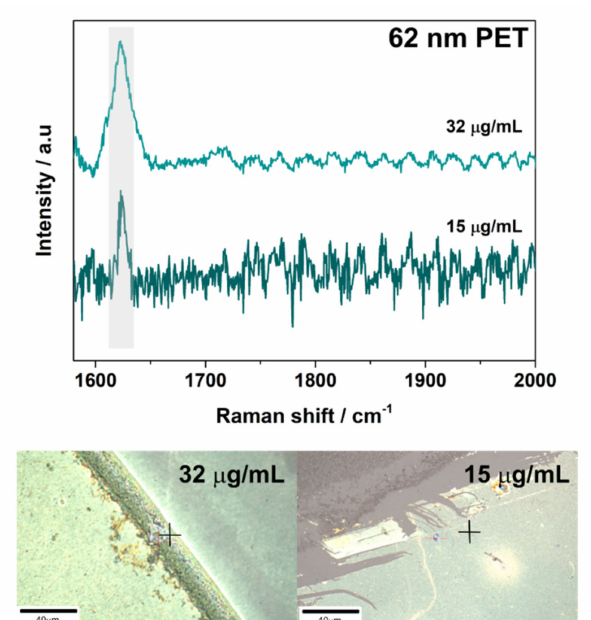
Figure 3. A representative SERS spectrum obtained for 62 nm PET nanoparticles on 46 nm AuNP substrates. The spectrum obtained is shown above images of the region of interest (ROI) the mea- surement was obtained from. Scale is 40 µ m. Laser power, scan speeds, and number of averaged accumulations for the samples can be viewed in Table